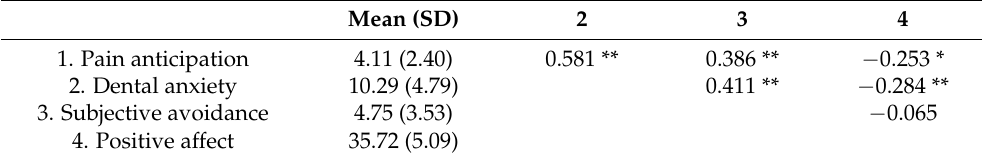
Table 1. Mean, standard deviation and correlation between outcome